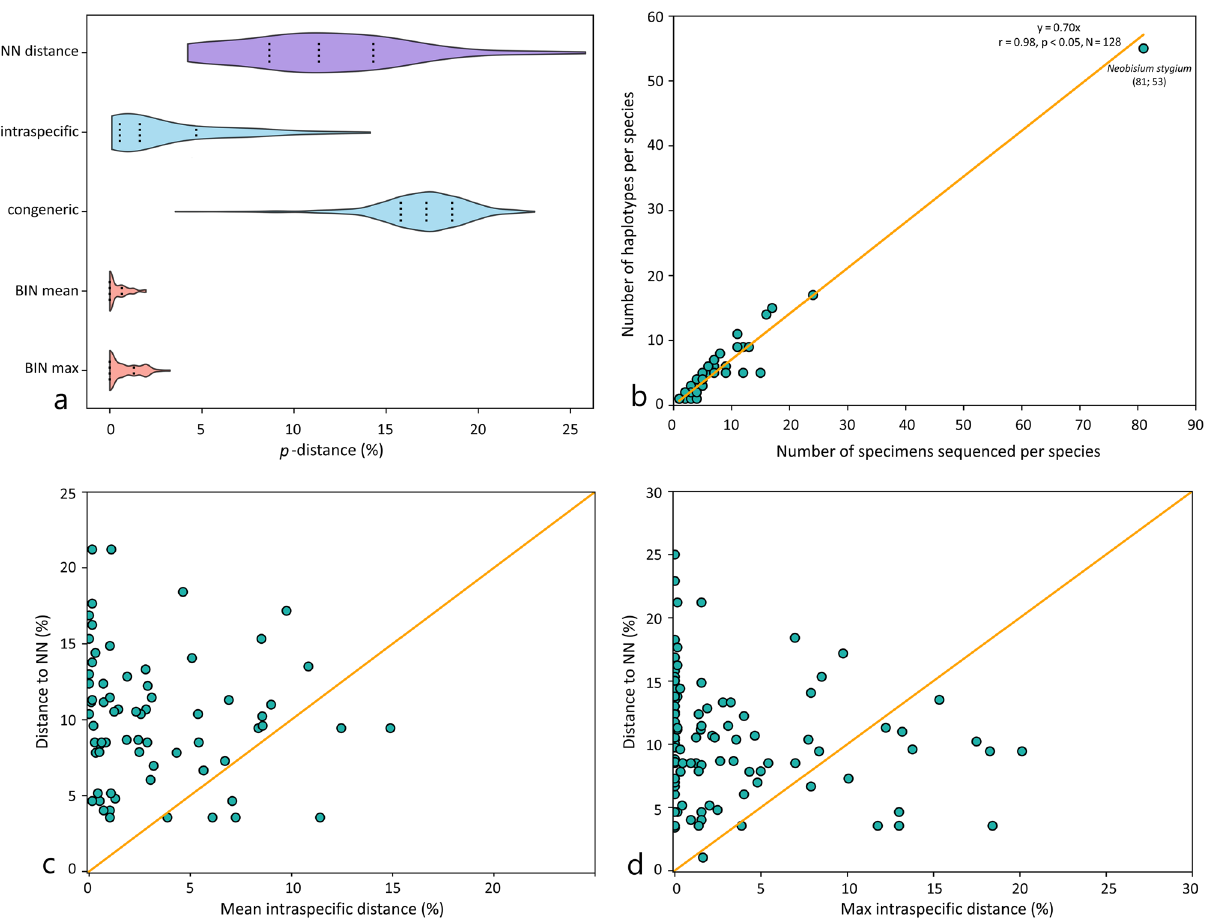
Figure 4. Intra- and interspecific diversity of pseudoscorpion species. Missing data was treated with pairwise deletion option. ( a ) Violin plot representing nearest-neighbour (NN), mean intraspecific and congeneric genetic distances, and BIN mean and maximal distances across all species in the dataset. The dashed lines inside indicate the first, middle, and third quartiles of the data. ( b ) Number of distinct haplotypes per species vs. specimens’ sequences per species. Correlation equation, Pearson correlation coefficient, probability ( p ), and species number are shown above graph. Neobisium stygium , most common species is indicated in the graph (number of specimens; number of haplotypes); ( c ) Mean intraspecific distances vs. minimum interspecific distances; ( d ) Maximal intraspecific distances vs. minimum interspecific